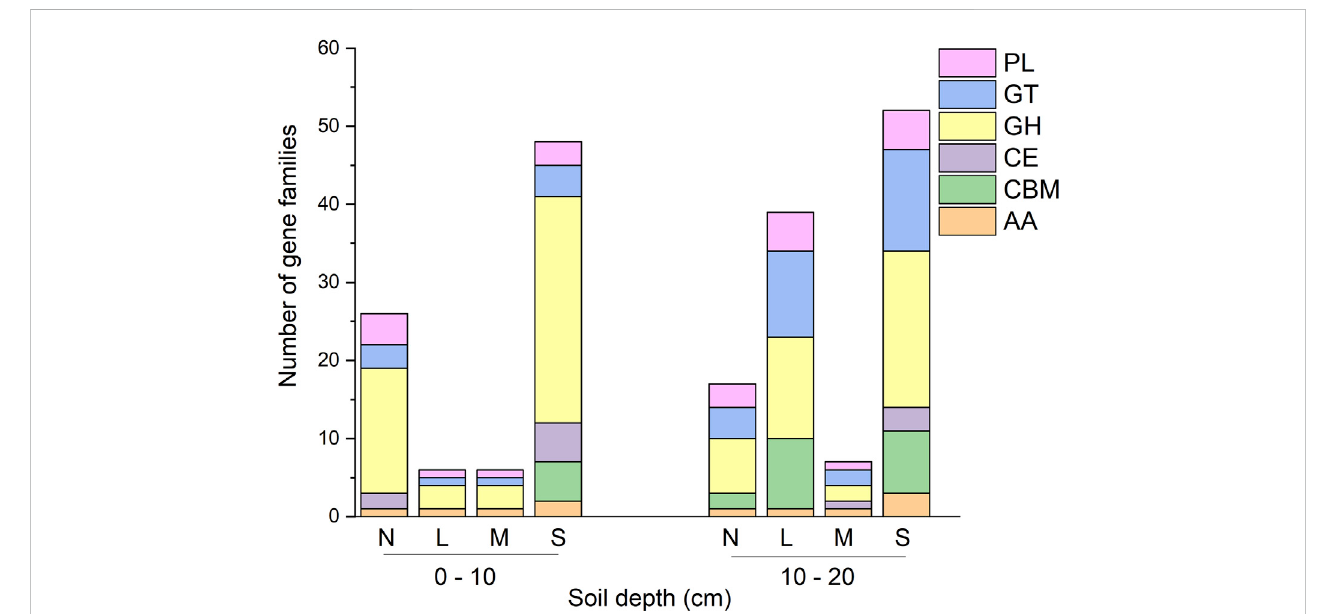
FIGURE 3 Richness of CAZyme indicator gene families that were found to be enriched in each degradation severity and soil depth. N: non-degraded; L: lightly degraded; M: moderately degraded; S: severely degraded.